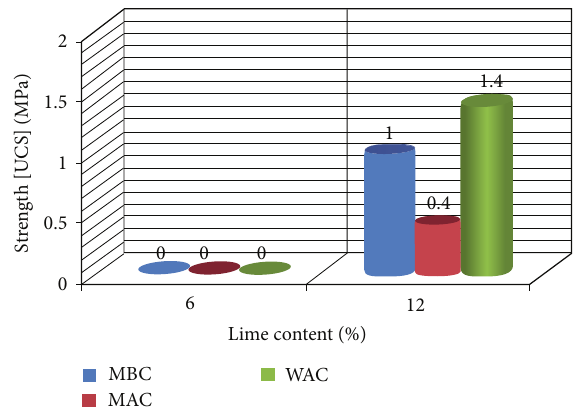
Figure 14: UCS of different lime contents (dry durability condi- tions).